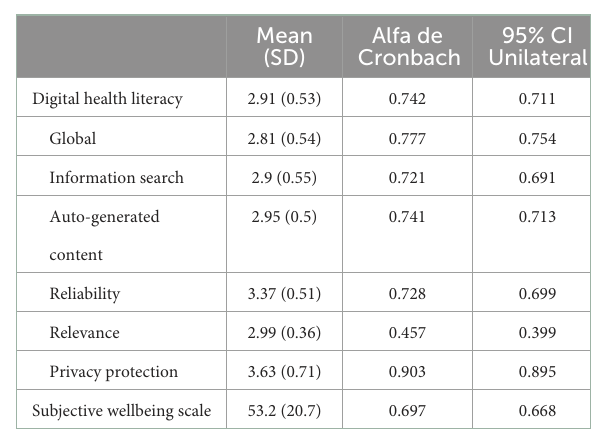
TABLE 2 Mean scores and Cronbach’s alpha for the DHL and subjective wellbeing